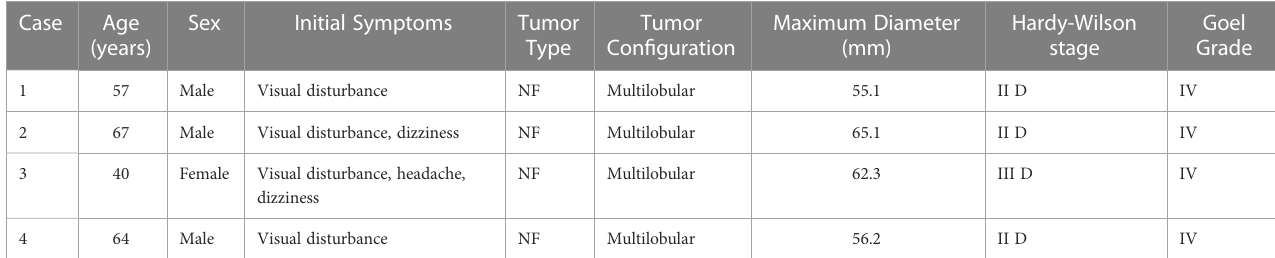
TABLE 1 Characteristics of patients.